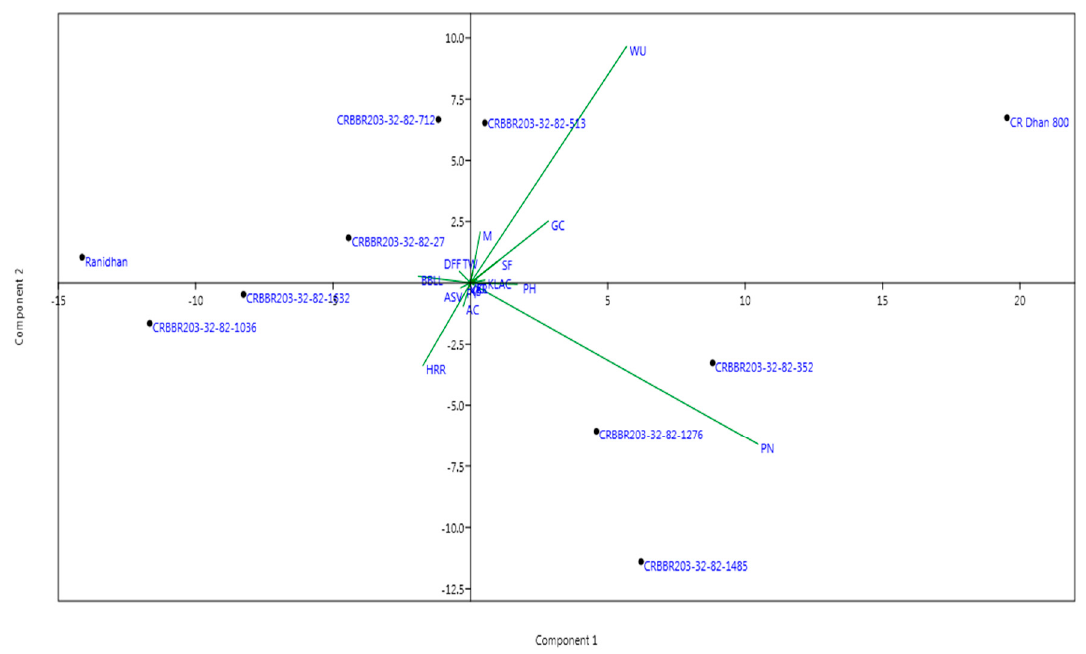
Figure 7. Biplot diagram of the 8 pyramided and parental lines of rice for the first two principal